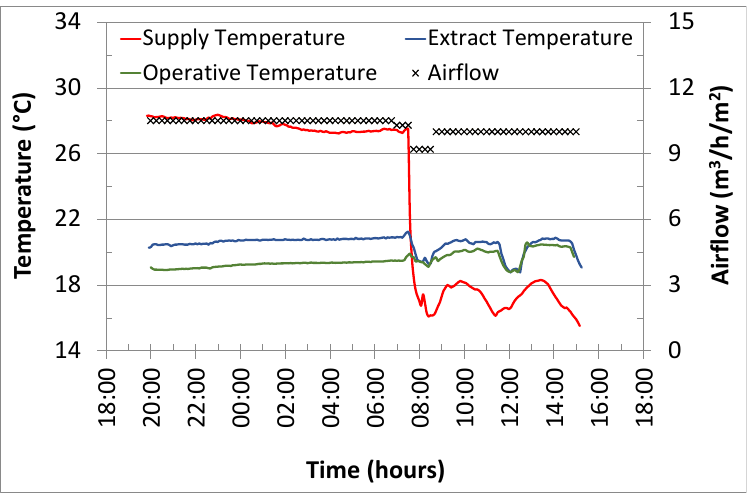
Figure 15 shows measured values of supply, extract and operative temperatures, and air- flows for the field test. Each temperature measurement in the figure is an average of two different sensors. The supply air temperature was measured in each of the two supply air diffusers. Similarly, the extract air temperature was measured in the two extract air grilles. The radiant air temperature was measured by the globe temperature sensor installed on each measurement pole. The operative temperature was calculated based on the measured air temperature, mean radiant temperature, and air velocity according to ISO 7726 [105].